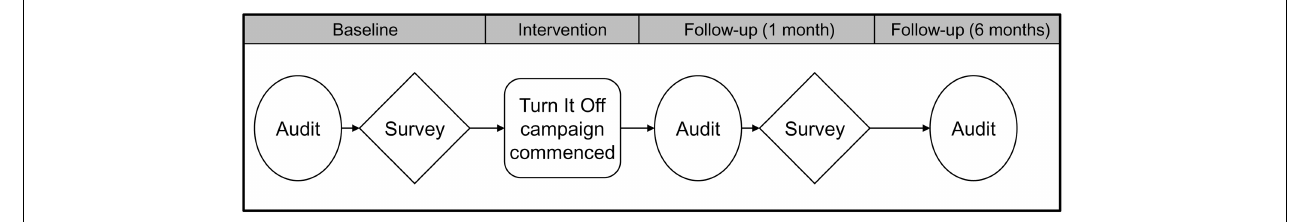
FIGURE 1 | Overview of the Turn It Off